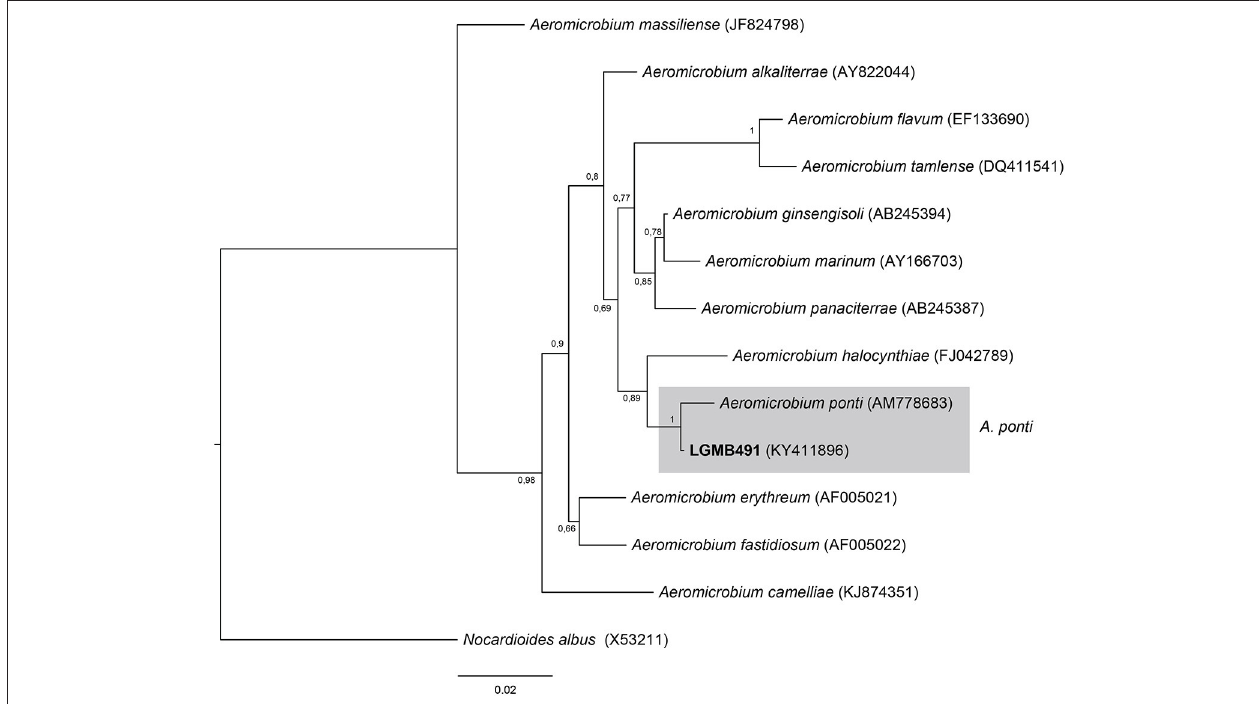
FIGURE 2 | Bayesian phylogenic tree based on 16S rRNA gene of LGMB491 and the 12 type strain of Aeromicrobium genus. Values on the node indicate Bayesian posterior probabilities. The species Nocardioides albus was used as out group. Scale bar indicates the number of substitutions per site.